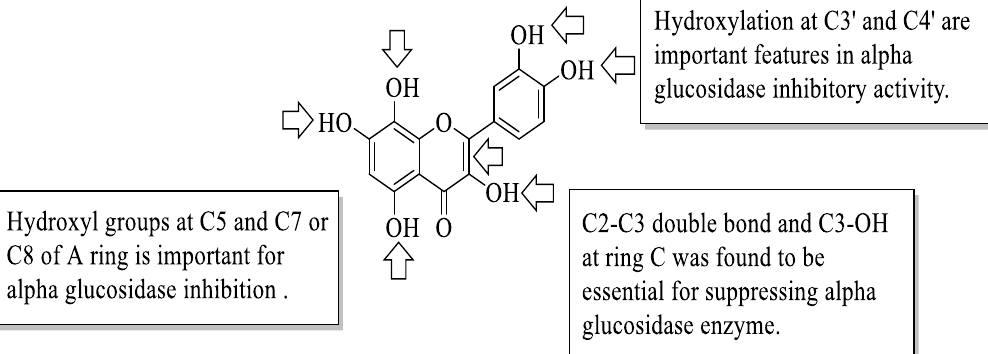
Figure 17. The SAR of flavonoids for α -glucosidase inhibition activity [54]. Similarly, Proença et al. studied the same series of 40 flavonoids. However, the bio- activity tested was slightly different, in which inhibition against pancreatic α -amylase was evaluated [55]. Like α -glucosidase inhibition, α -amylase inhibition is also considered one of the T2D management, as it catalyses the hydrolysis of starch to simple sugar. Acarbose was also used in this study as a positive control. It was revealed that the compound with the most effective inhibition was 62 (3-chloro- 3′ , 4′ ,5,7-tetrahydroxyflavone) with an IC 50 value of 44 ± 3 μM. Then, based on this most -active compound, an activity pattern was created by the authors. Based on Figure 18, it was found that the presence of a Cl atom at C3 and the C2–C3 double bond of the C-ring was important for strong inhibition. Furthermore, the presence of hydroxyl groups at C5 and C7 of the A- ring, as well as C3′ and C4′ of the B-ring was also responsible for α -amylase inhibition. In addition, the authors discussed that the position and nature of substituents were also the determinants for the α -amylase inhibition of flavonoids.